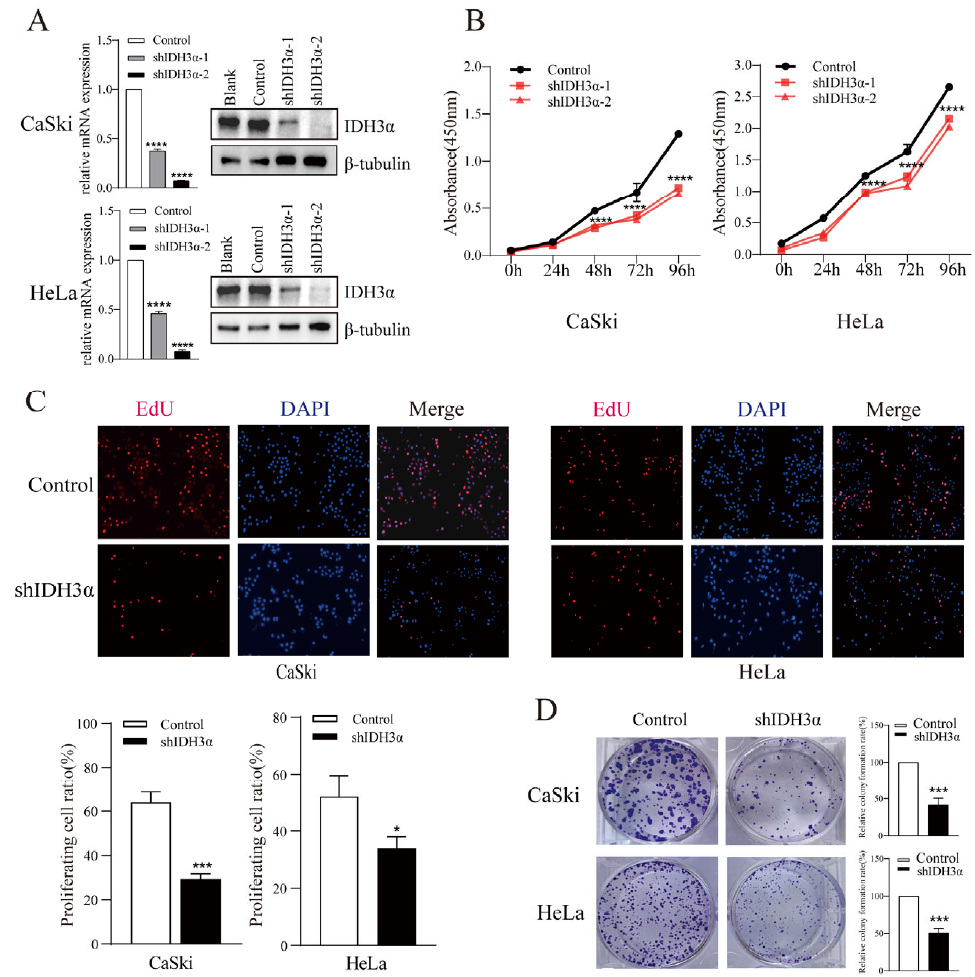
Figure 2. The effects of IDH3 α knockdown on proliferation, apoptosis, and cell cycle distribution in multiple cancer cell lines. ( A ) IDH3 α -knockdown CaSki and HeLa cells were confirmed using qPCR and WB. ( B , C ) CCK-8 assay ( B ) and EdU assay ( C ) showed that the silencing of IDH3 α expression suppressed cell vitality. ( D ) The silencing of IDH3 α suppressed colony-forming ability in UCC cells. Data are shown as mean ± SD. * p < 0.05, *** p < 0.001, and **** p < 0.0001.